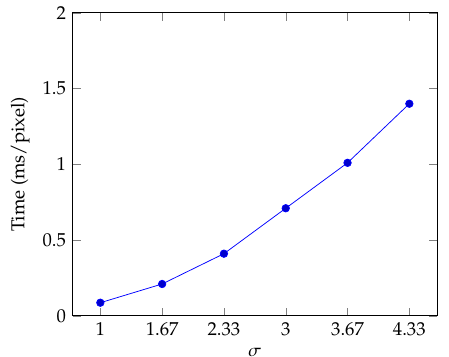
Figure 6. Prediction time in milliseconds per pixel (ms/pixel) depending on the Gaussian window size σ